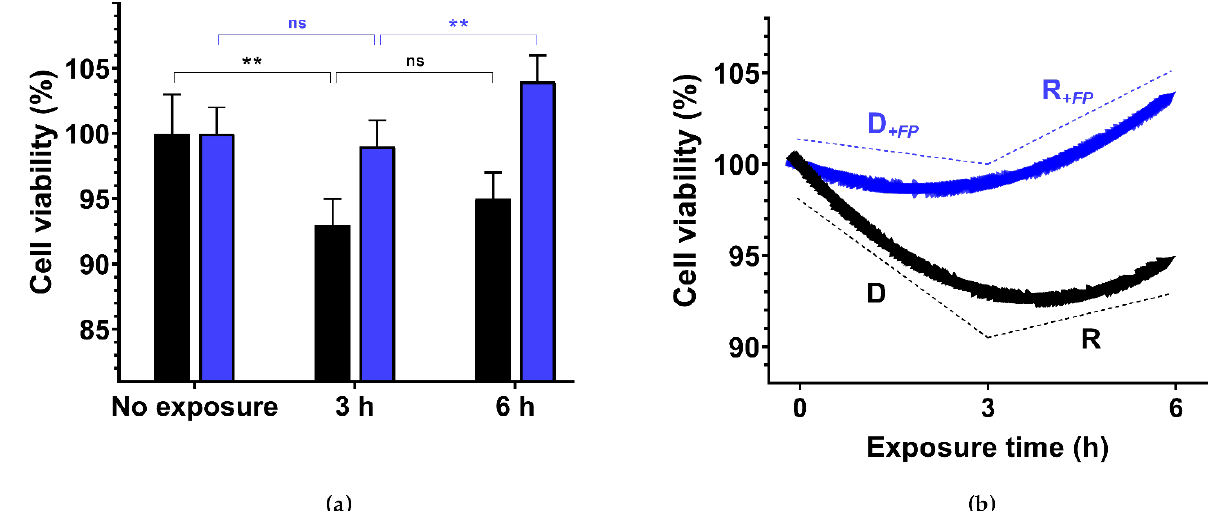
Figure 3. Vero epithelial cell metabolic viability ( a ) and its corresponding temporal evolution ( b ) post-ROS induction with an acute H 2 O 2 concentration. Viability is shown as mean absorbance data, in the presence (blue) or absence (black) of FucoPol for non-exposed cells, and cells exposed to 300 µM H 2 O 2 for 3 and 6 h. The corresponding evolution of viability over time, shown as decay–recovery response curves, were modeled with the following linear segments: D ( y = − 2.33 t + 100), D +FP ( y = − 0.33 t + 100), R ( y = +0.67 t + 91), and R +FP ( y = +1.67 t + 94). Two-tailed t -student tests between time points were employed to check for statistical significance. Data were normality distributed, according to Anderson–Darling, D’Agostino and Pearson, Shapiro–Wilk, and Kolmogorov–Smirnov normality tests. The ** symbol represents p < 0.0021 statistical significance for 95% CI.